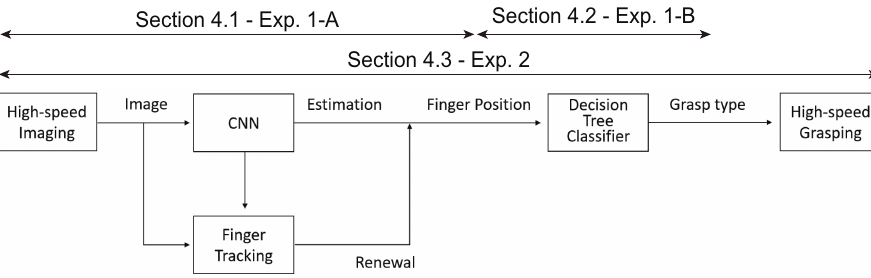
Figure 8. Overview of experiments and